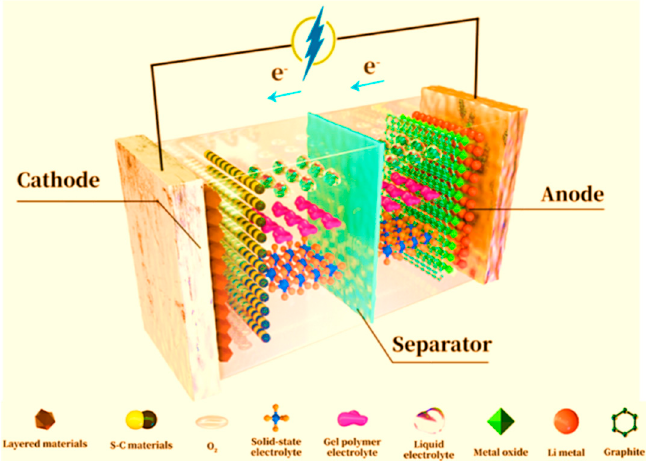
Figure 2. Schematic depiction of lithium insertion/de-insertion mechanism for current rechargeable lithium battery with various electrode materials.